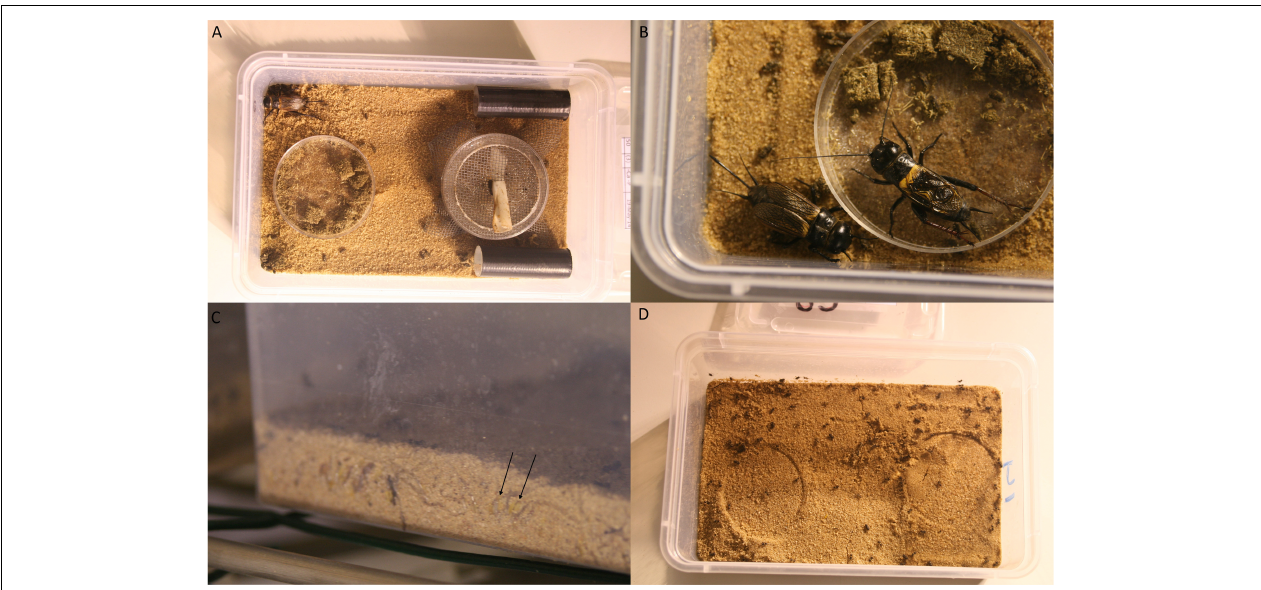
FIGURE 1 | Overview of the experimental setup of the feeding experiment. (A) Overview of experimental container (lid removed). (B) Adult male and female field cricket in feeding container. (C) Deposited eggs visible at the sand/container interface (2 of them indicated with arrows). (D) Hatched first instar nymphs in